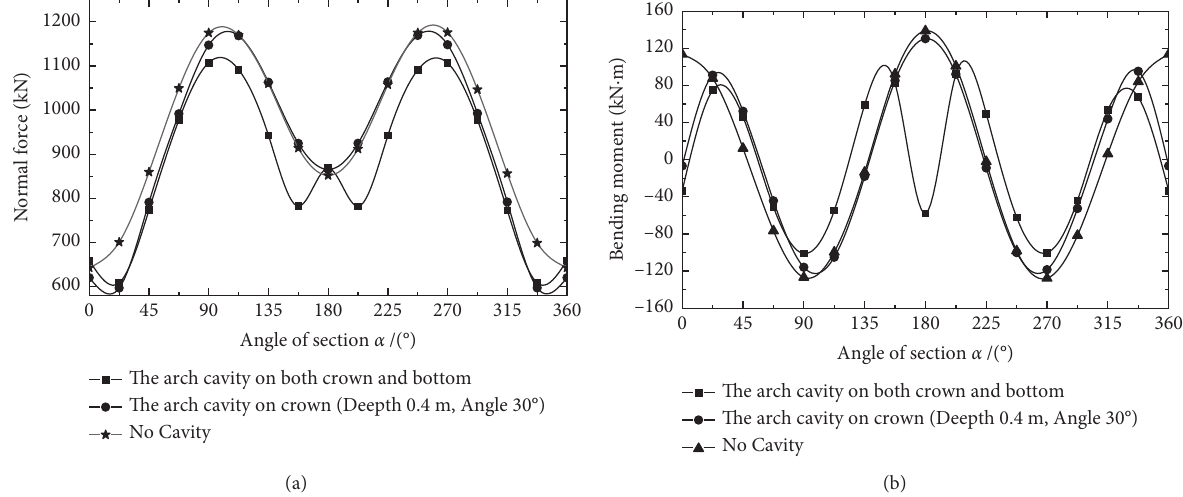
Figure 26: Internal force diagram of the cavity behind the arch waist and arch bottom. (a) Segment axial force. (b) Segment bending